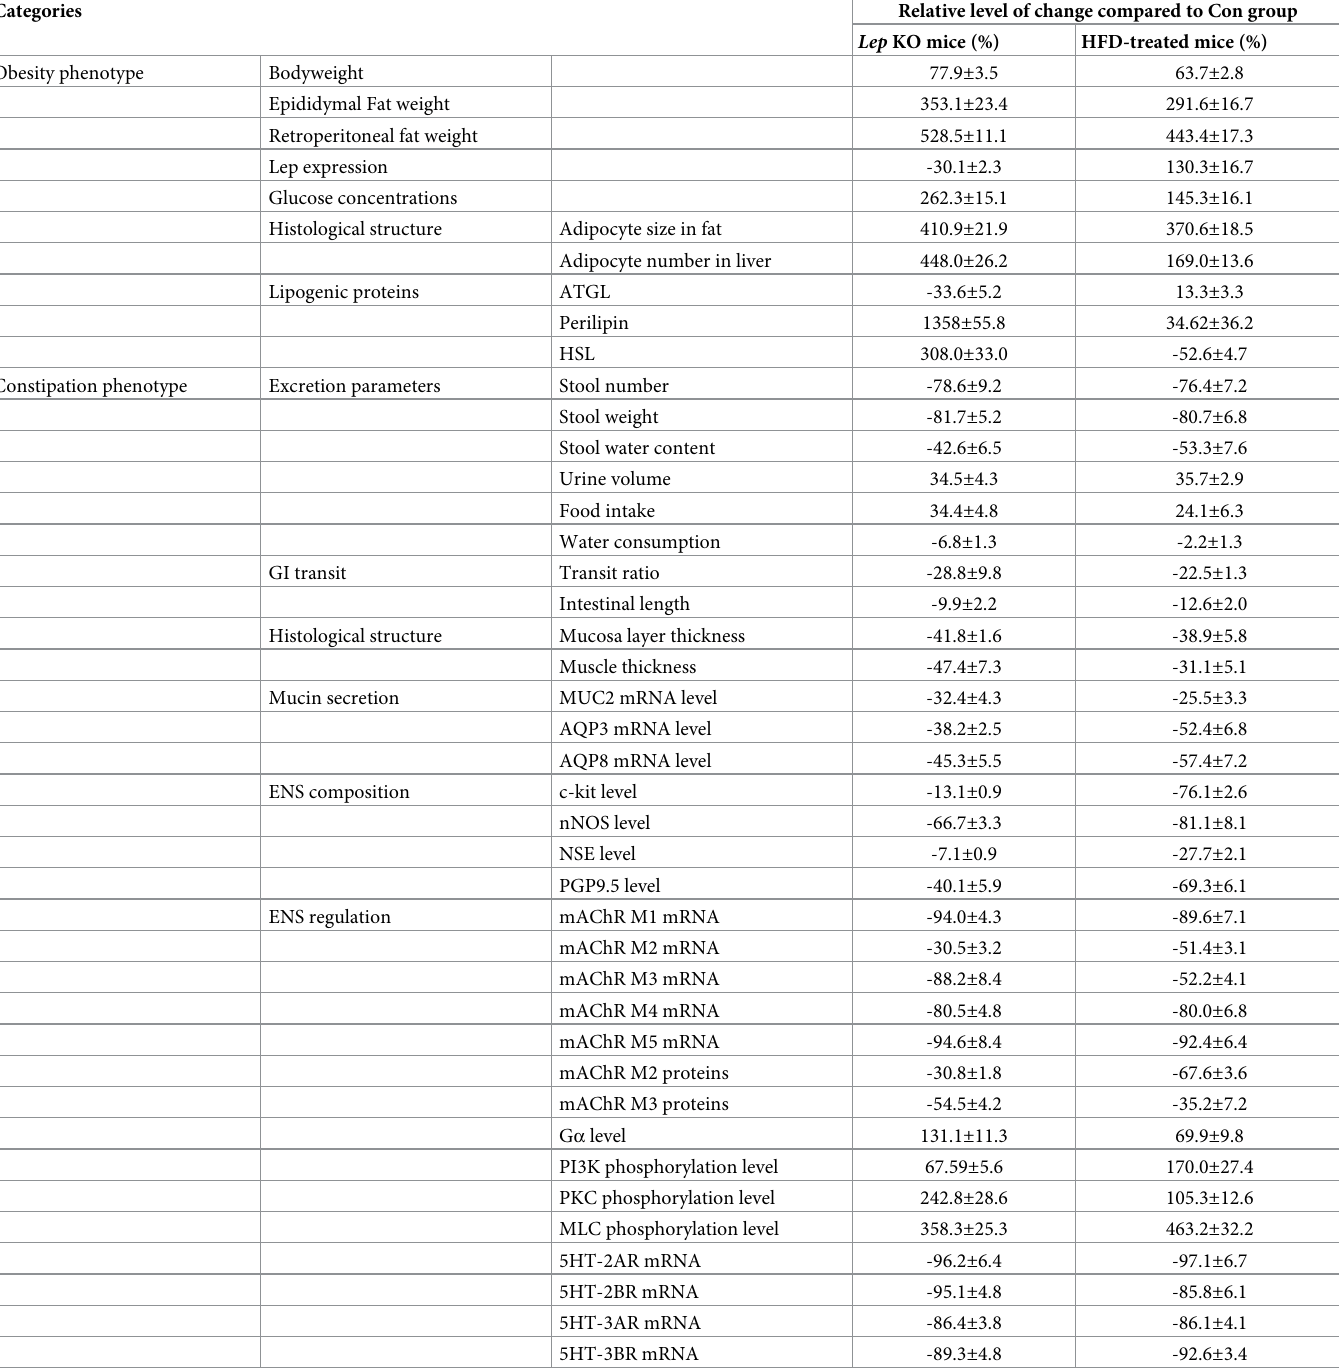
Table 1. Similarities and differences in obesity and constipation phenotypes between the Lep KO and HFD-treated mice. The minus sign indicates a decrease com- pared to the Con mice, and the plus sign indicates an increase in the same condition.